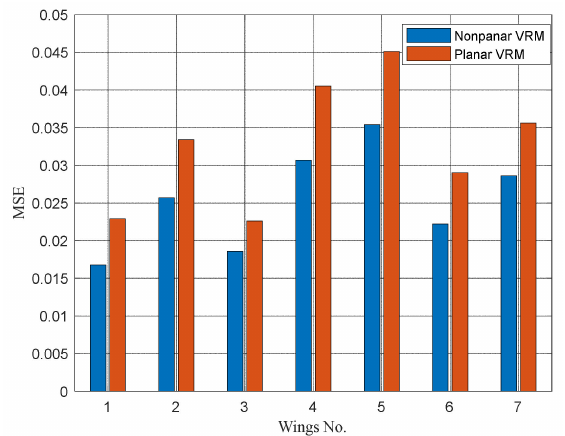
Figure 9. Mean square error (MSE) of nonplanar and planar vortex ring method (VRM).